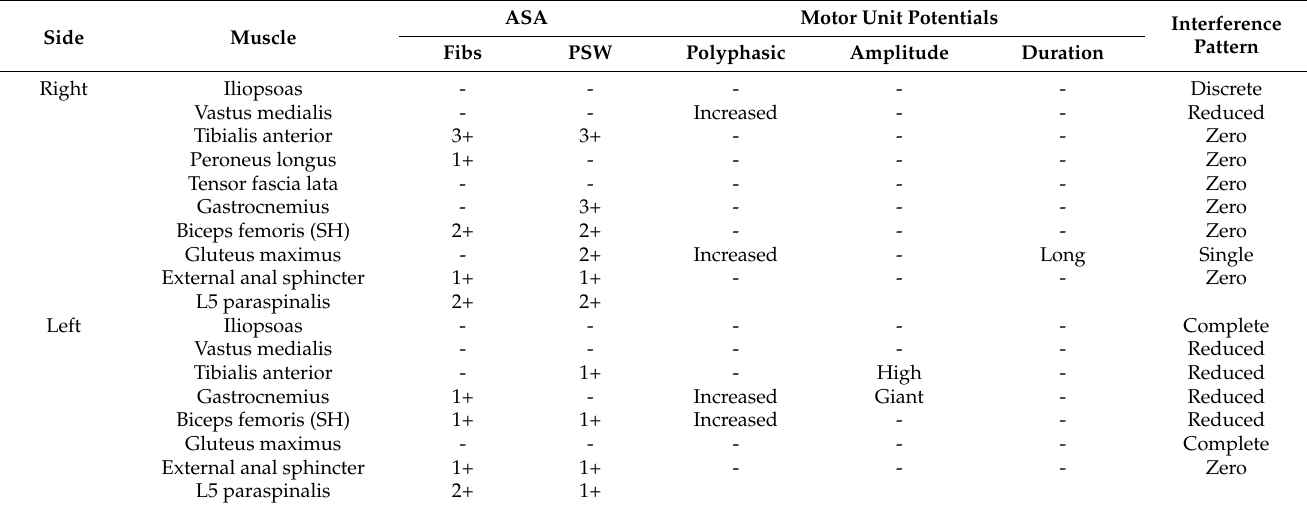
Table 2. Result of